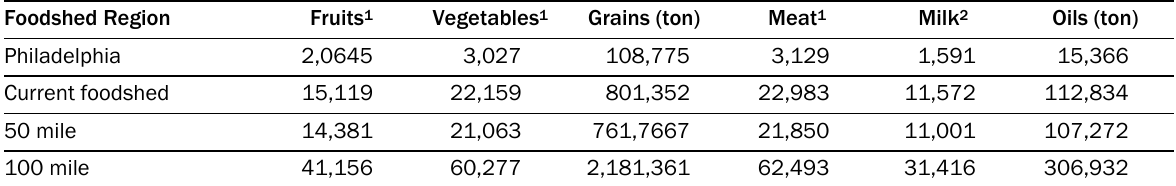
Table 5. Total Food Requirements in Philadelphia and the Three Foodshed Regions According to the DGA Foodshed Region